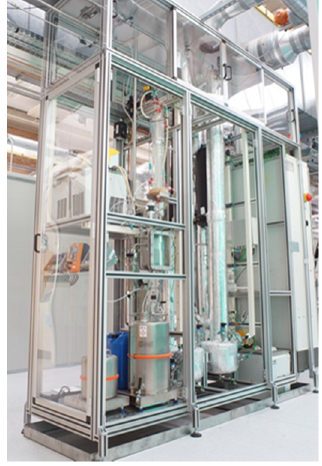
Figure 8. Bio-upscaled AREA-5 at TNO.